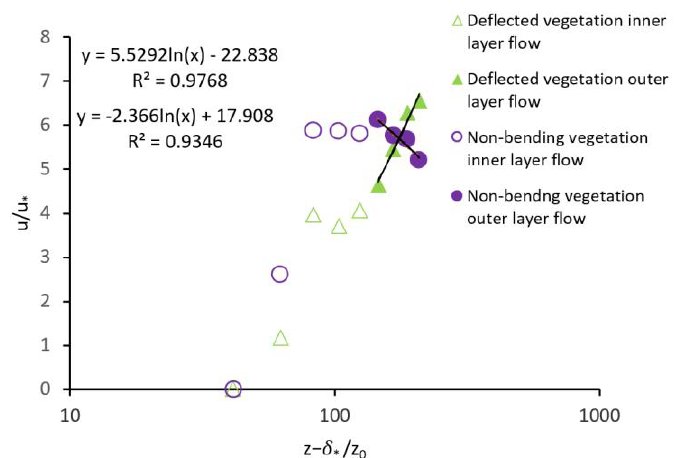
Figure 6. One sample of fitting Logarithmic Law distribution on the upper layer of velocity profile in a deflected and non-bending vegetation (staggered arrangement, flow depth: 30 cm).